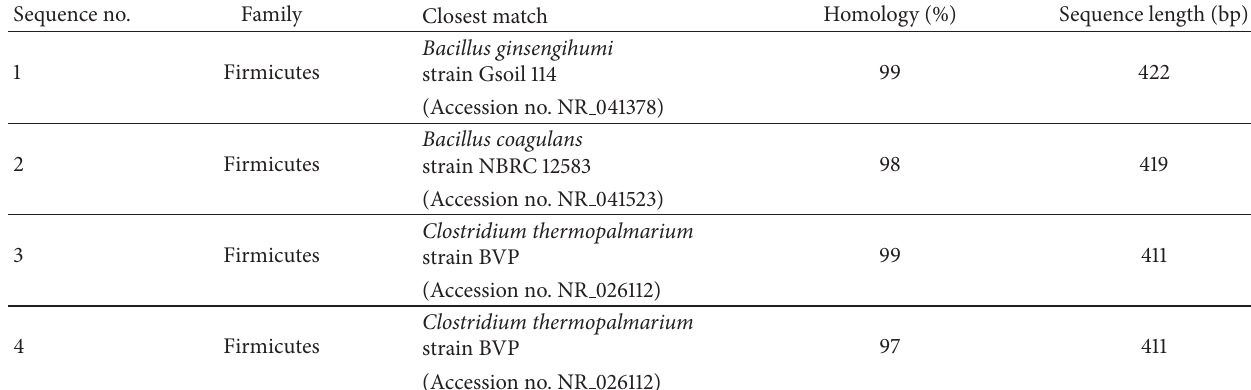
Table 5: Affiliation of DGGE fragments determined by their 16S rDNA and isolated microorganisms. Sequence no.